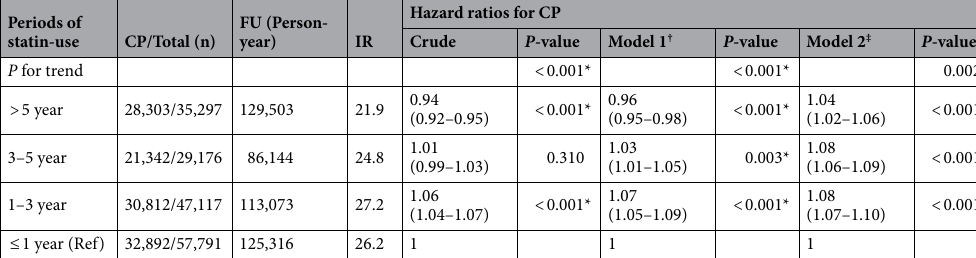
Table 4. Hazard ratio (95% confidence interval) for CP according to the periods of statin-use (n = 169,381). FU Follow-up duration, IR Incidence rate per 100 person-years, CCI Charlson comorbidity index, CP chronic periodontitis. *Un-stratified Cox proportional hazard model, Significance at P < 0.05. † A model 1 was adjusted for total cholesterol, systolic blood pressure, diastolic blood pressure, fasting blood glucose, obesity, smoking, alcohol consumption, and CCI scores. ‡ A model 2 was adjusted for model 1 plus dyslipidemia history and the number of previous